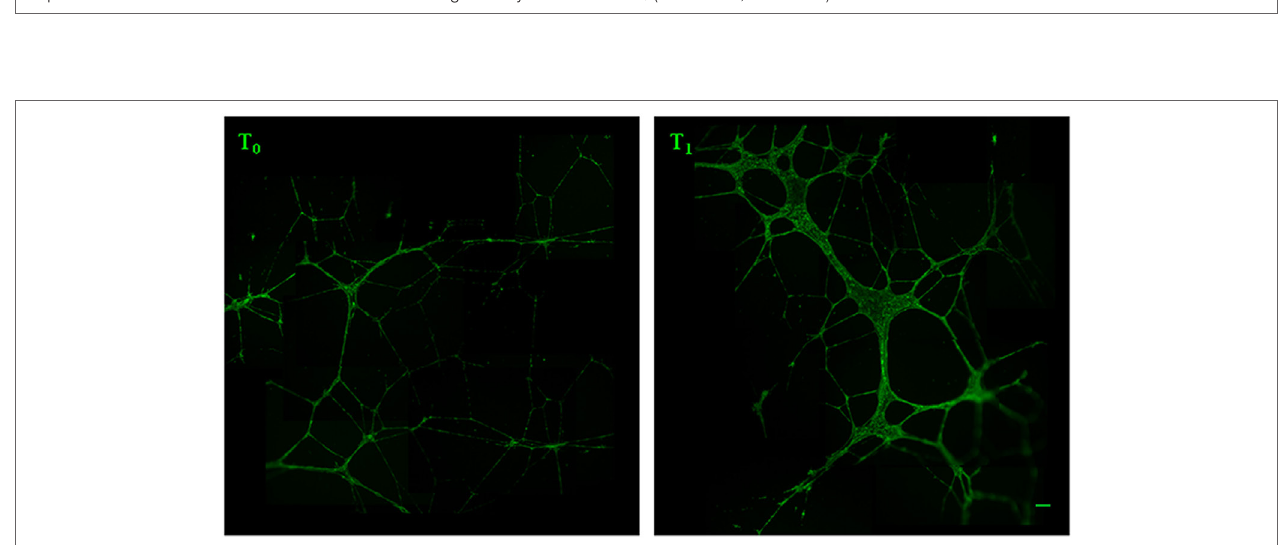
FigUre 3 | Analysis of capillary-like tube formation. Human umbilical vein endothelial cells were cultured in Matrigel with 5% serum obtained from the women before ( T 0 ) and after ( T 1 ) the training period. After 16 h, live endothelial cells were labeled with calcein AM (green fluorescence) and the tubes formation was analyzed by measuring the capillary-like structure width and area. Original magnification: 5 × . Bar scale: 40